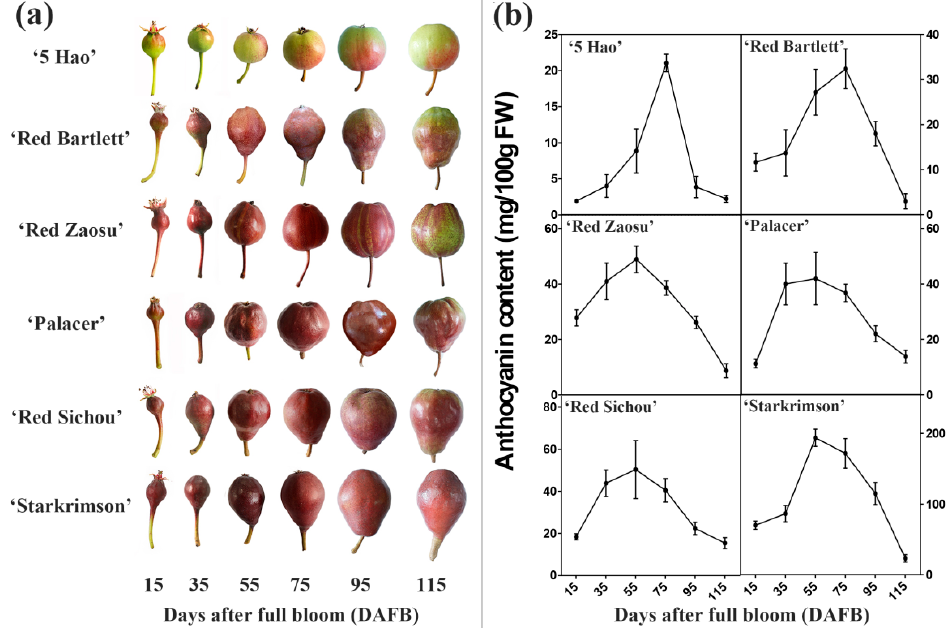
Figure 1. Changes in six red pear cultivars’ skin color and anthocyanin contents at different stages of fruit development. ( a ) The phenotypes and changes in skin color at different stages of fruit development. ( b ) The total anthocyanin contents at different stages of fruit development. Data are means ± standard deviations of three biological replicates.